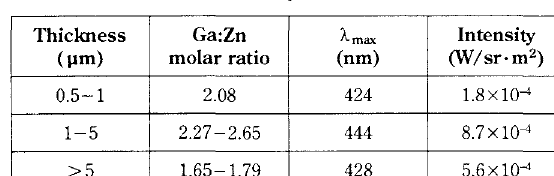
Table 2 Film thickness, Ga:Zn molar ratio, peak maximum and intensity for four films of zinc gallate prepared by super critical C0 2 -assisted deposition.